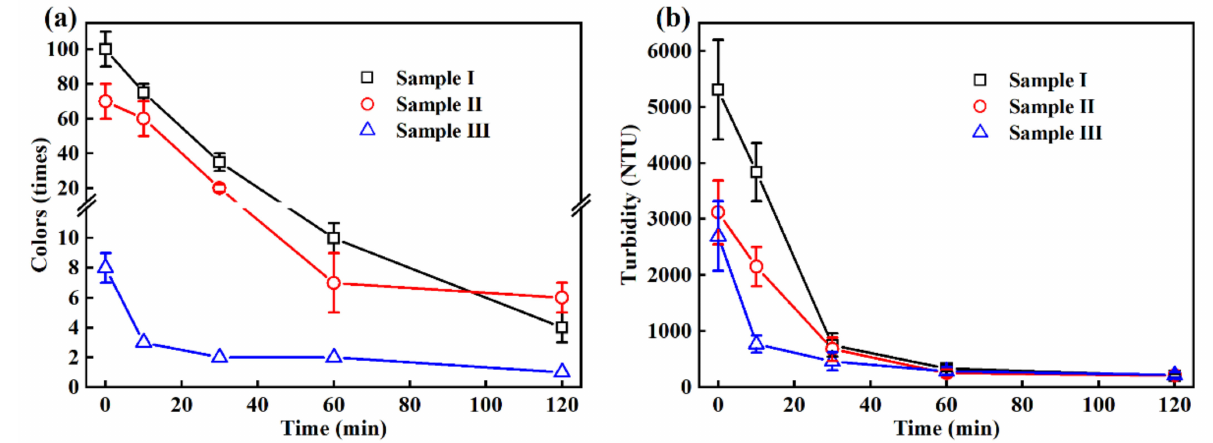
Figure 1. Changes in ( a ) colors and ( b ) turbidity of wastewater in EO treatment at 50 mA/cm 2 current density.